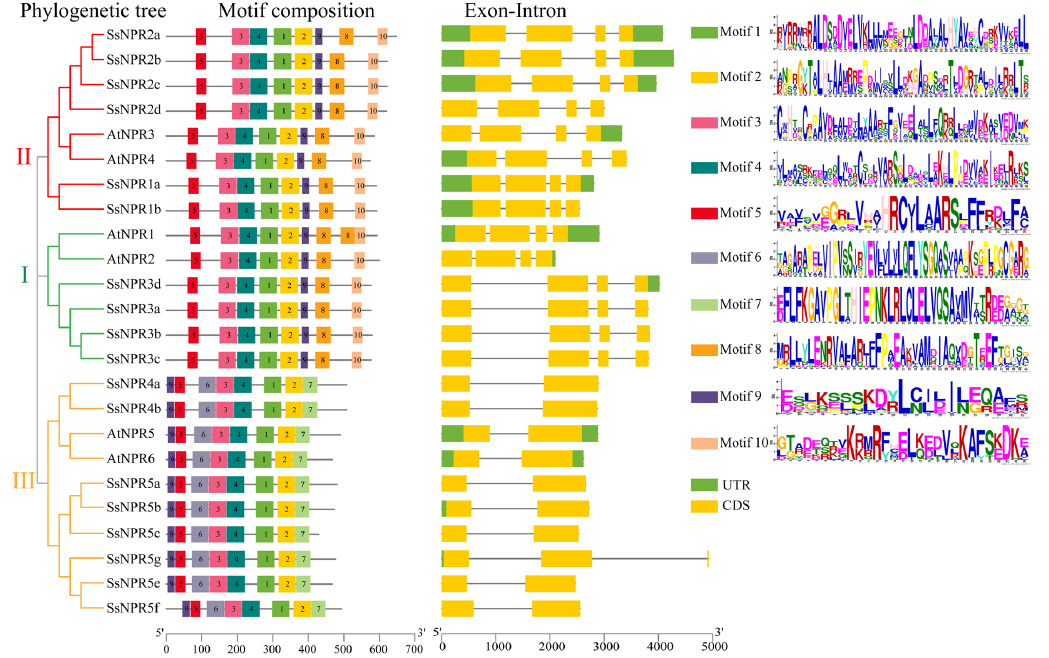
Figure 2. Phylogenetic tree, conserved motif, and gene structure of the NPR1-like proteins in Saccharum spontaneum and Arabidopsis. Different colors on the phylogenetic tree represent different clades of the NPR1 -like gene family and different colored boxes indicate different motifs (motif 1–10). The noncoding sequences, exons, and introns are shown as green boxes, yellow boxes, and black lines in the exon–intron structures, respectively. The length of proteins and genes is estimated using the scale at the bottom.